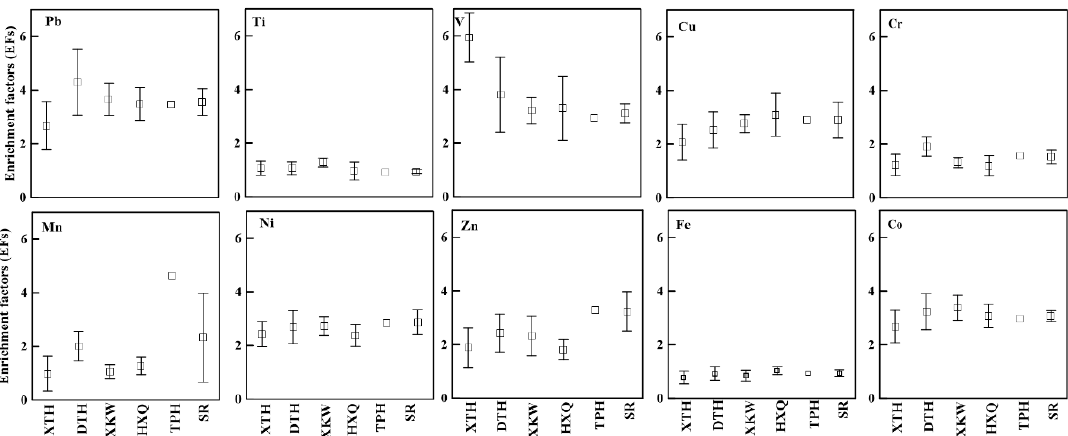
Figure 3. Enrichment factors (EFs) of heavy metals in sediments of Taihu Lake and rivers.